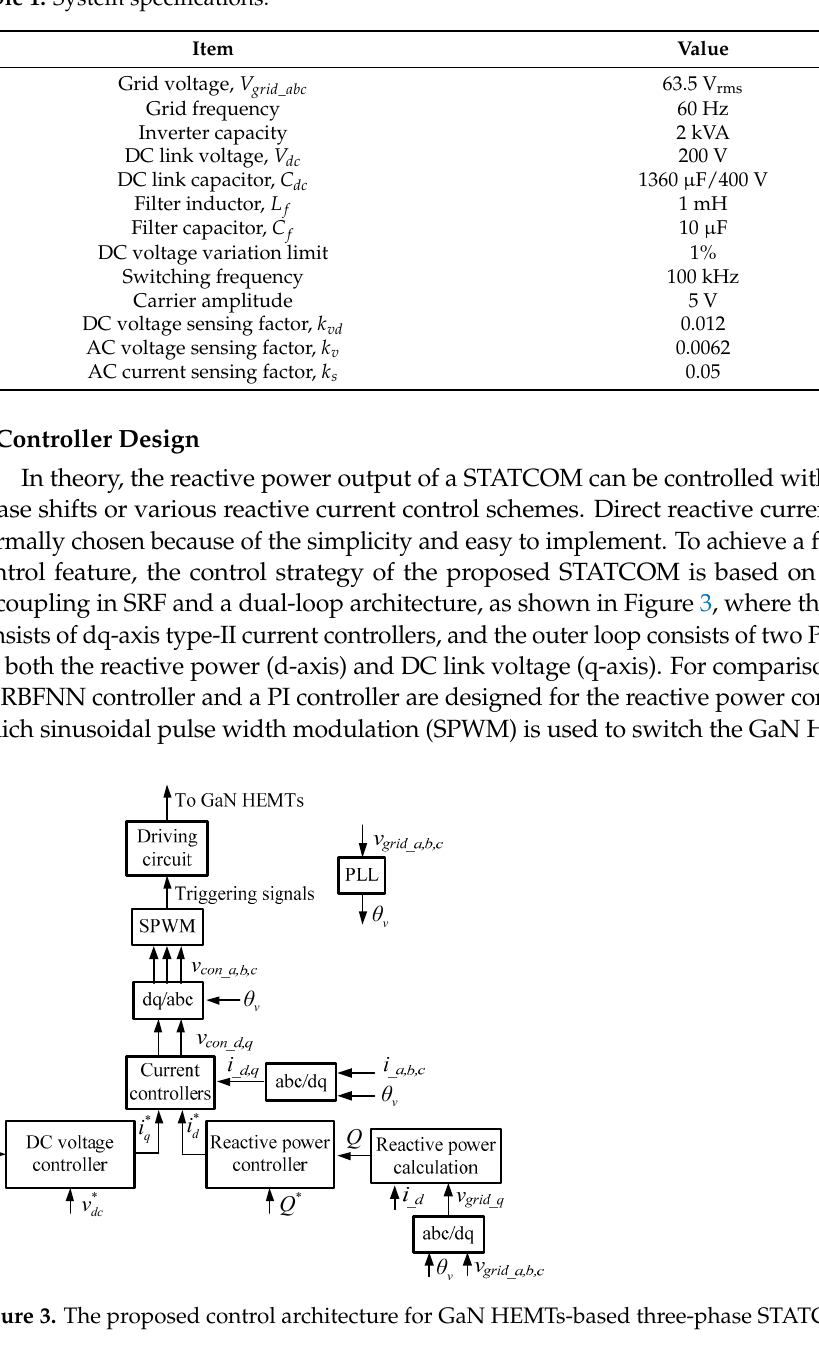
Figure 2. The circuit topology of the proposed GaN HEMTs-based STATCOM. Table 1. System specifications.